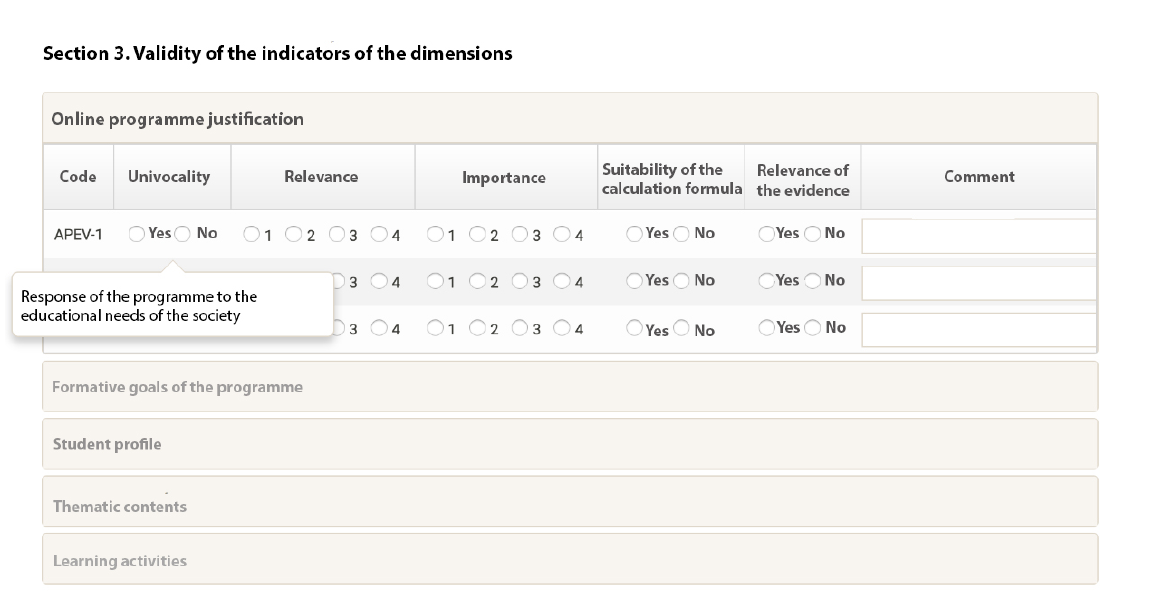
Figure 2. A screenshot of the online validation form (section 2).